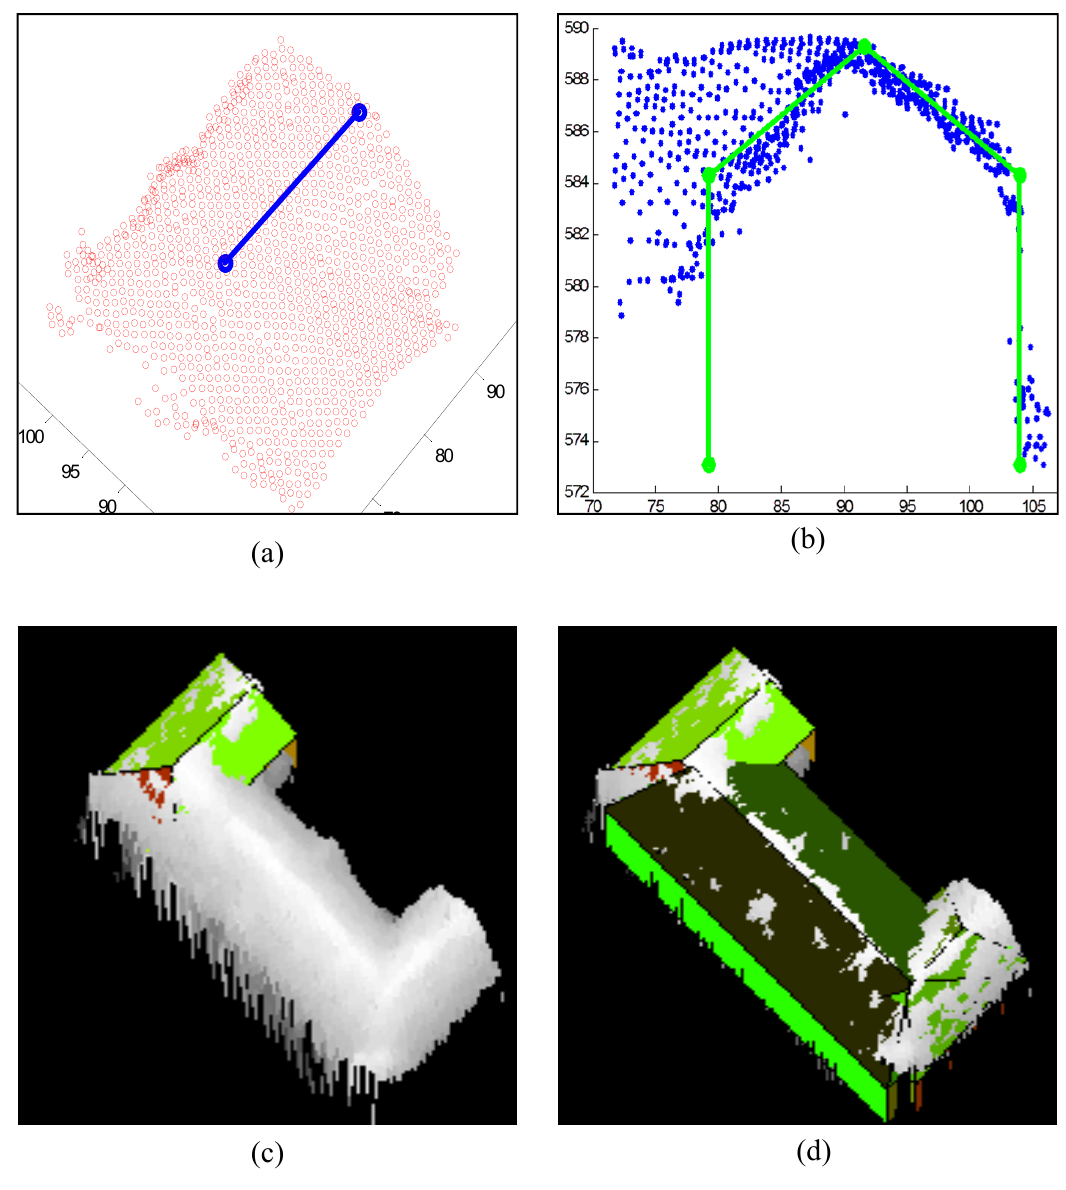
Figure 7. Projection-based model generation. ( a ) Localized pixels; ( b ) Fitting 2D model; ( c ) 3D model of building part; ( d ) Merge parametric